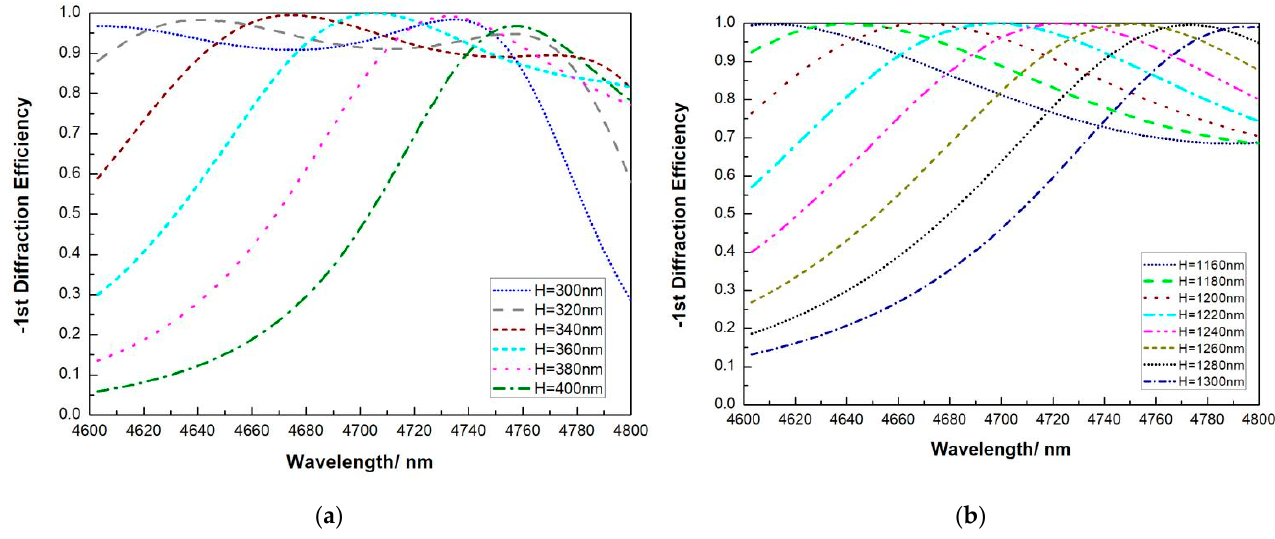
Figure 4. First-order DE versus wavelength with pure Si grating when the grating depth H changes ( a ) from 300 nm to 400 nm and ( b ) from 1160 nm to 1300 nm. At around 4.7 μ m, both 0.36 μ m and 1.220 μ m of pure Si gratings satisfy the highest DE of more than 99.99%. At grating depth of 0.36 μ m, the DE at 4.6 μ m is 30.52%, the DE at 4.8 μ m is 81.58%. A range of 4.687–4.727 μ m has a DE of more than 96%. At a grating depth of 1.22 μ m, the DE at 4.6 μ m is 57.06% and the DE at 4.8 μ m is 74.26%. A range of 4.672–4.726 μ m has a DE of more than 96%. Deeper grating depth has larger working wavelength range, yet the etching condition becomes tougher.